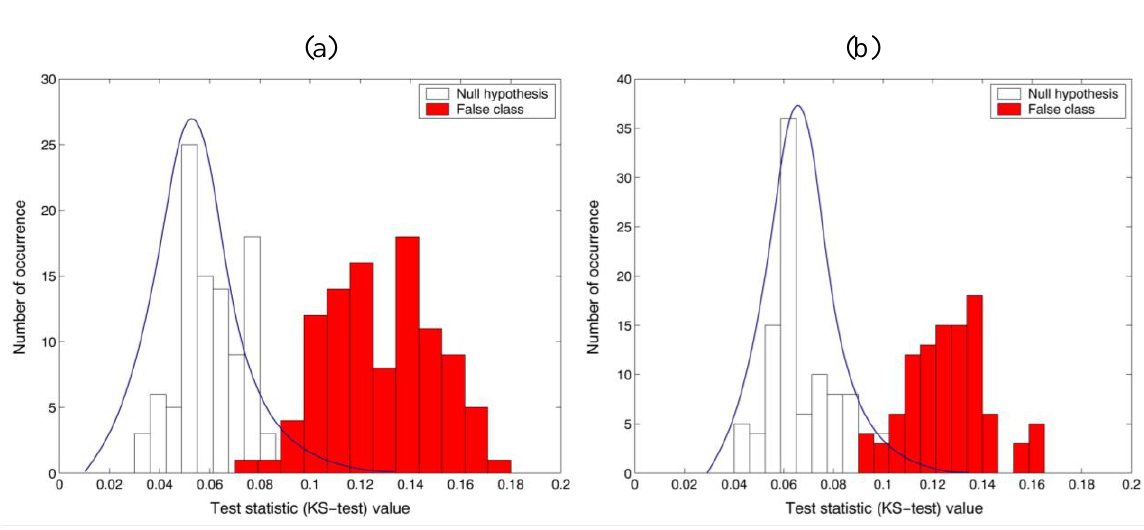
Figure 6. Nonparametric KS-test results for the equality of two variances. 200 test pixel points were selected from segmented holographic image. (a) real part and (b) imaginary part in the reconstructed image. Reference: Oscillatoria bacteria. False class: Diatom alga.